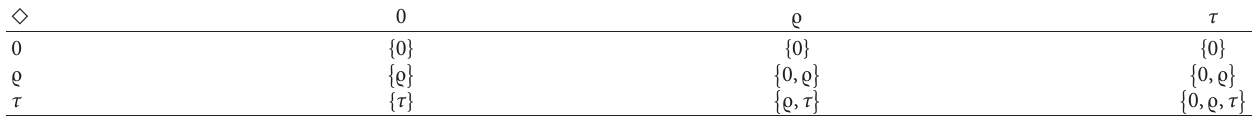
Table 1: Tabular representation of the hyperoperation “ ◇ .”